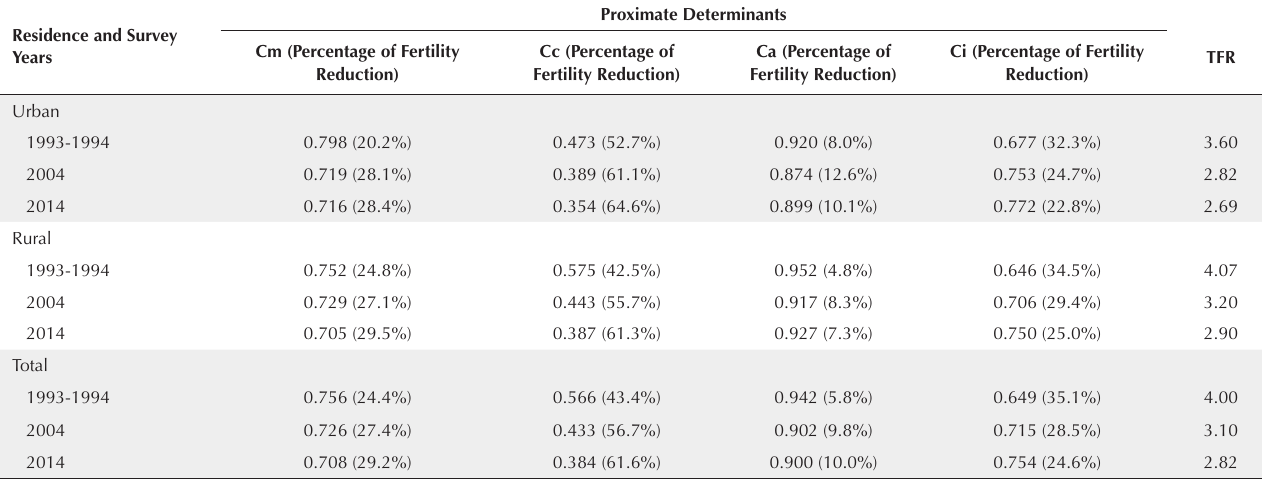
TFR Cm (Percentage of Fertility